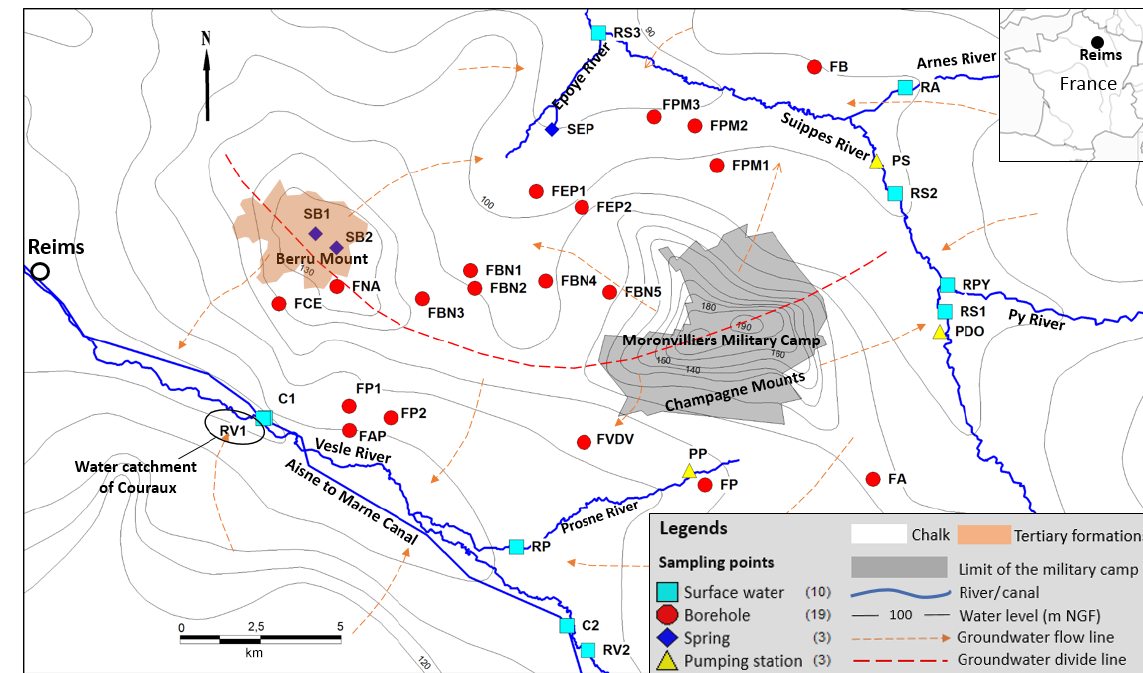
Figure 1. Location of the study area, main rivers and sampling points (water level data from Rouxel-David et al.,